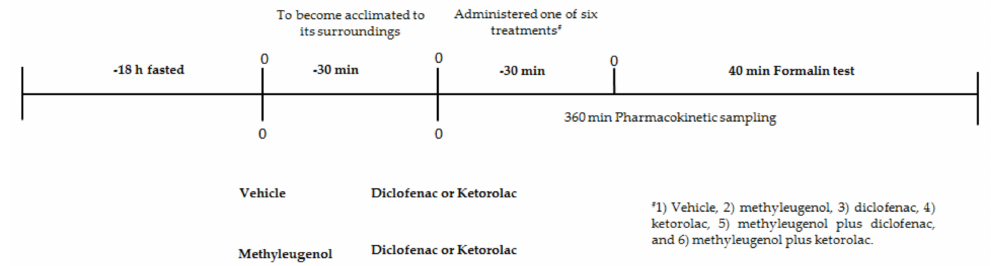
Figure 3. Timeline of the experimental